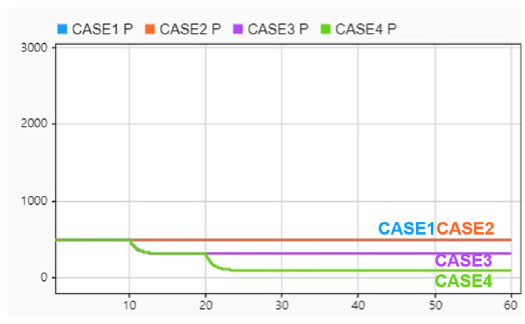
Figure 19. Active power output of the G2 inverter.